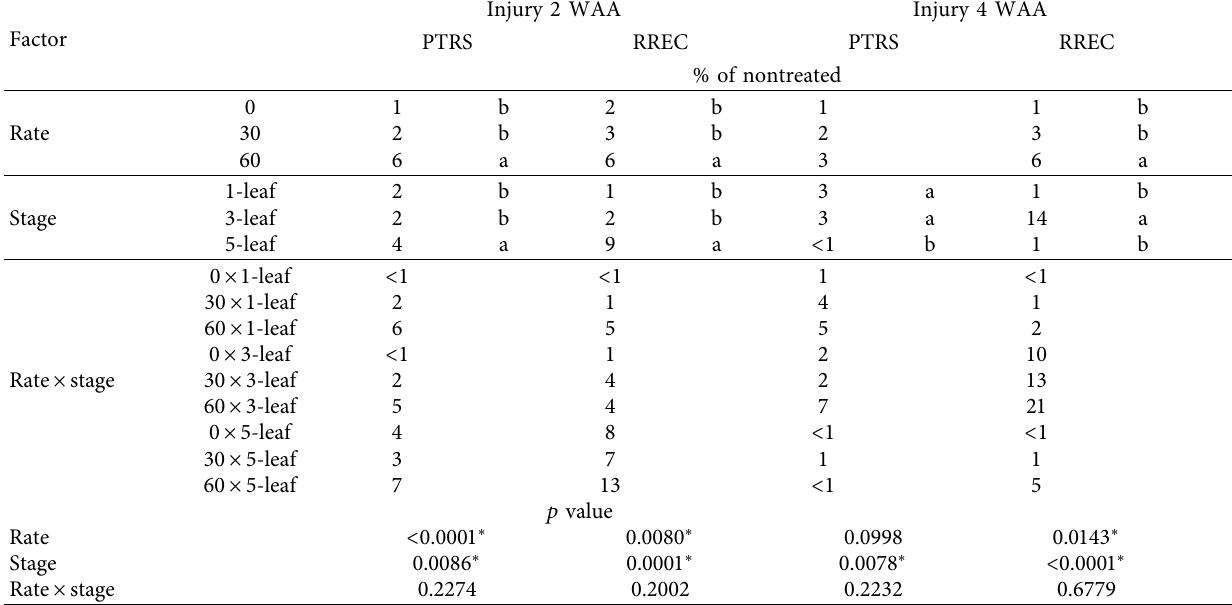
Table 6: Rice injury for CLXL745 as influenced by florpyrauxifen-benzyl rate applied with imazethapyr at various rice growth stages a,b,c .